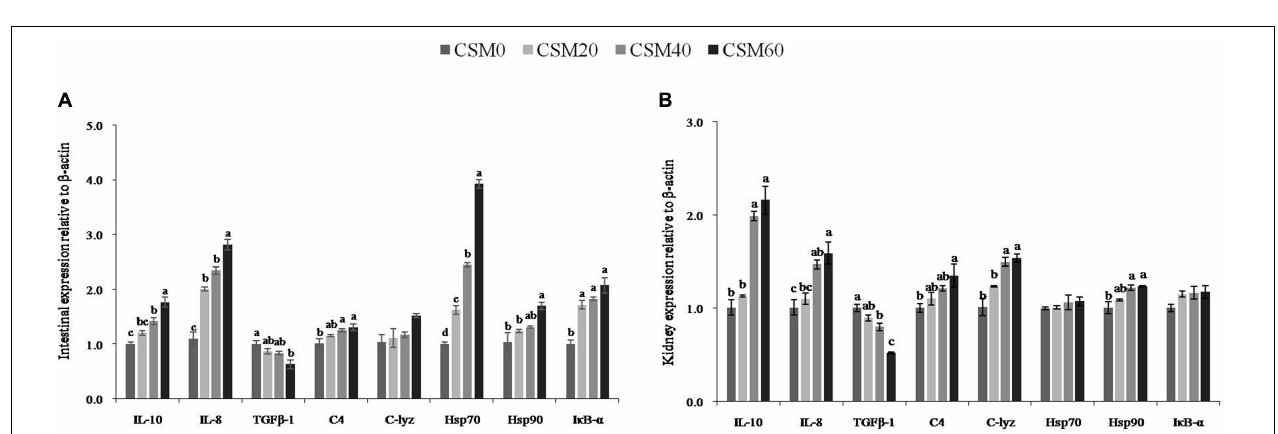
FIGURE 4 | The intestine and kidney gene expression pattern of the key regulators in antioxidant defense after juvenile golden pompano ( Trachinotus ovatus ) fed with CSM0, CSM20, CSM40 and CSM60 diets, respectively. (A) Intestine. (B) Kidney. Values with different superscripted small letters mean significant difference ( P < 0.05). MnSOD, Manganese superoxide dismutase; CAT, catalase; Nrf2, NF-E2-related nuclear factor 2; Keap1, Kelch-like-ECH-associated protein 1; HO-1, heme oxygenase-1.